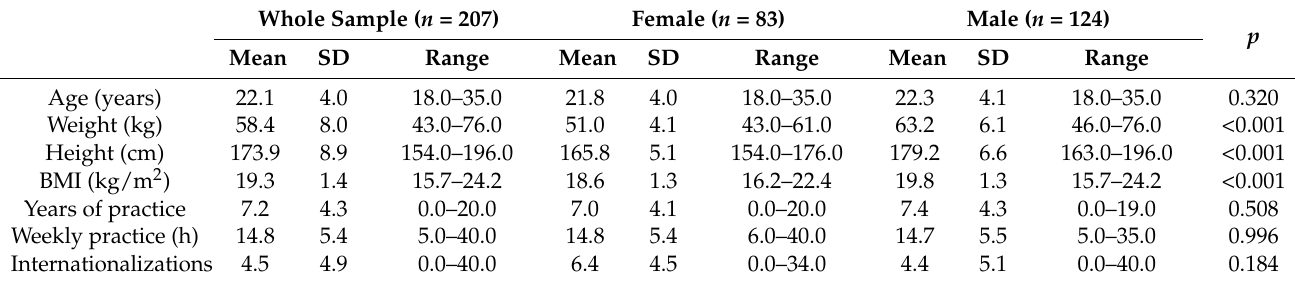
Table 1. Anthropometric and training characteristics of the sample and divided by sex.